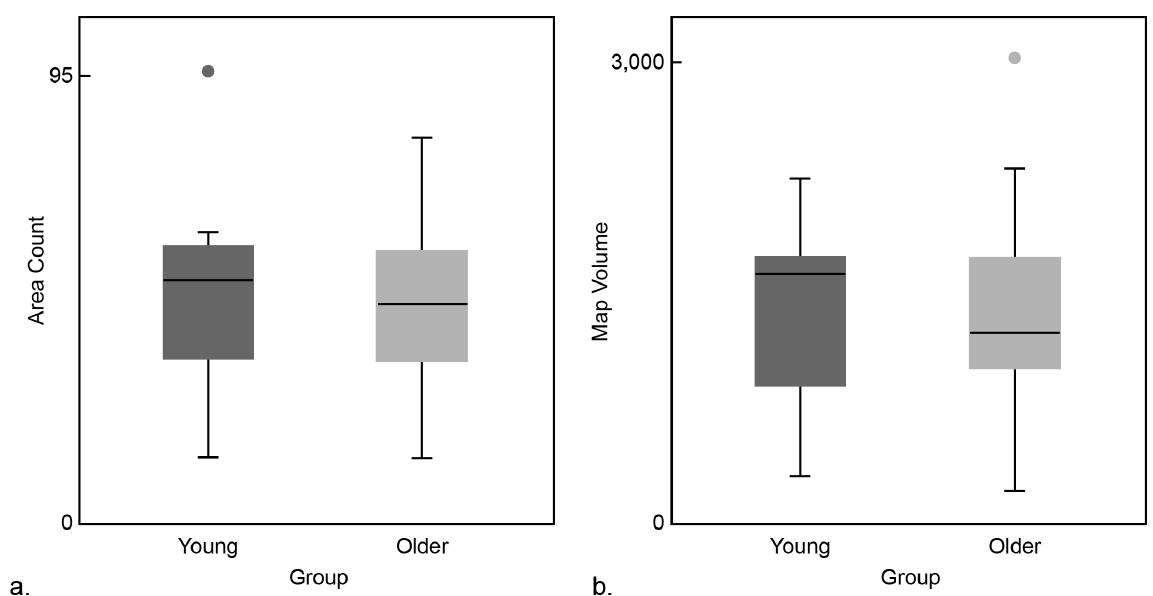
Figure 4. Map size and volume in young and old individuals. Differences between young and old subjects with respect to (a) map size or sites on scalp that are included in the motor map for left biceps muscle and (b) map volume. The groups did not differ significantly upon either measure although there is a seemingly higher count and volume in the younger group.